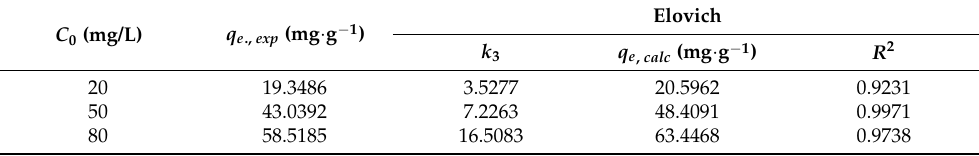
Table 3. Elovich model parameters of MO on